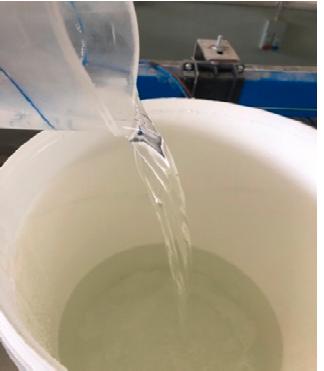
Figure 2. Aqueous suspension of colloidal